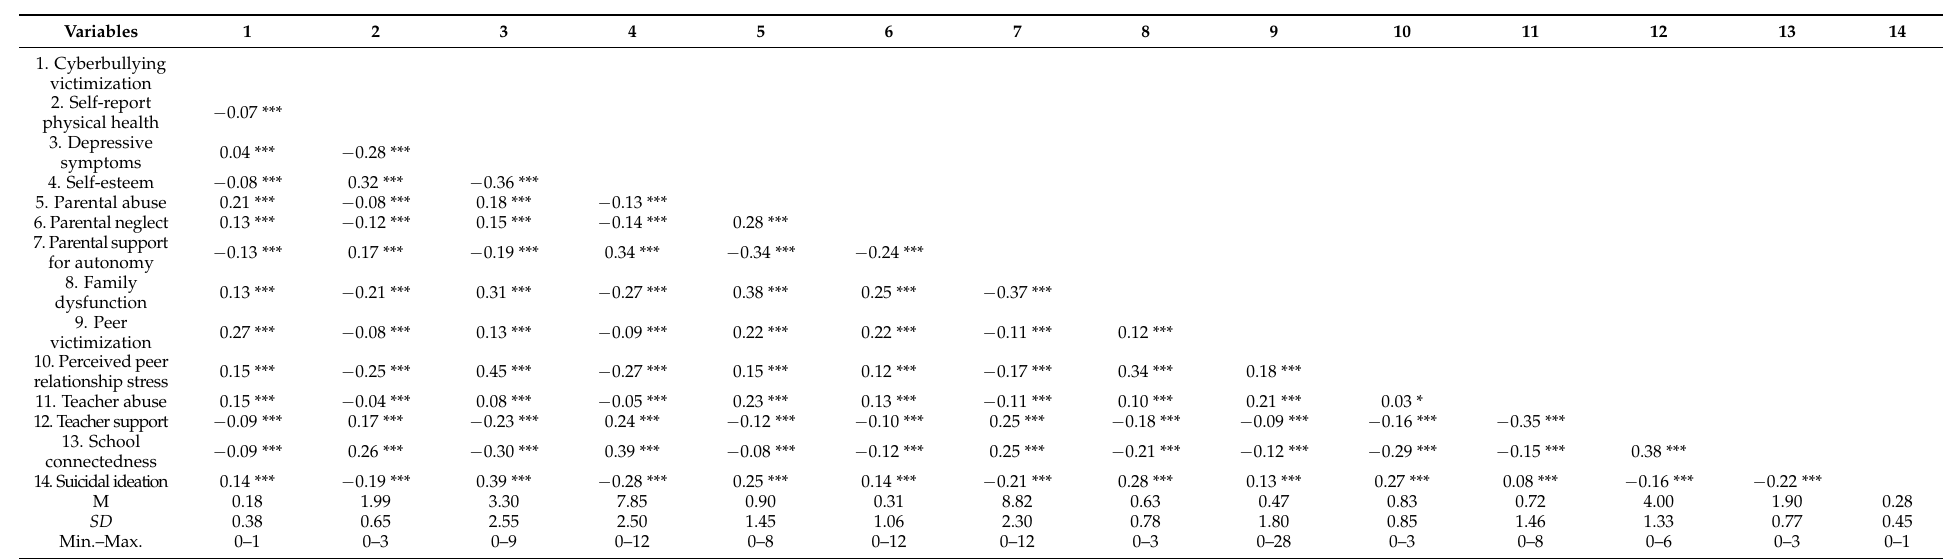
Table 2. Bivariate correlations of the key study